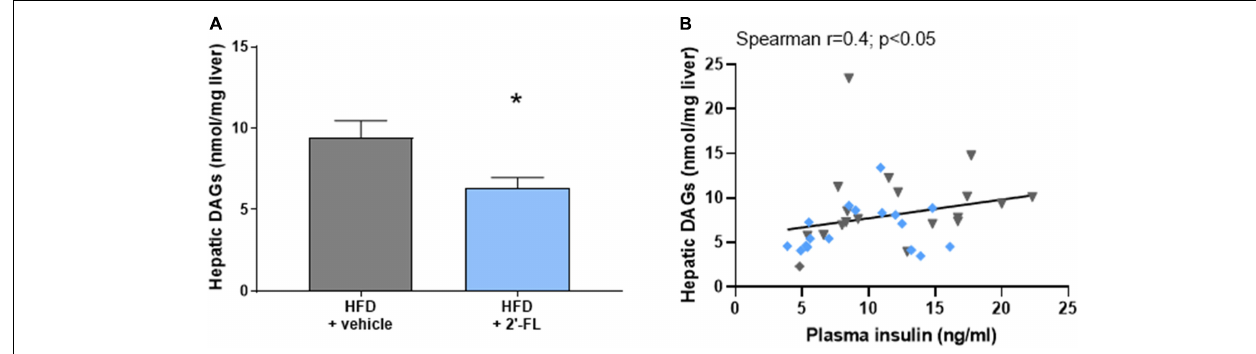
FIGURE 5 | Human milk oligosaccharide 2 (cid:48) -FL reduced (A) total intrahepatic diacylglycerols (DAGs). (B) Total DAGs correlated with fasting plasma insulin concentrations. Data is from n = 18 mice per treatment group shown as mean ± SEM, * p < 0.05.